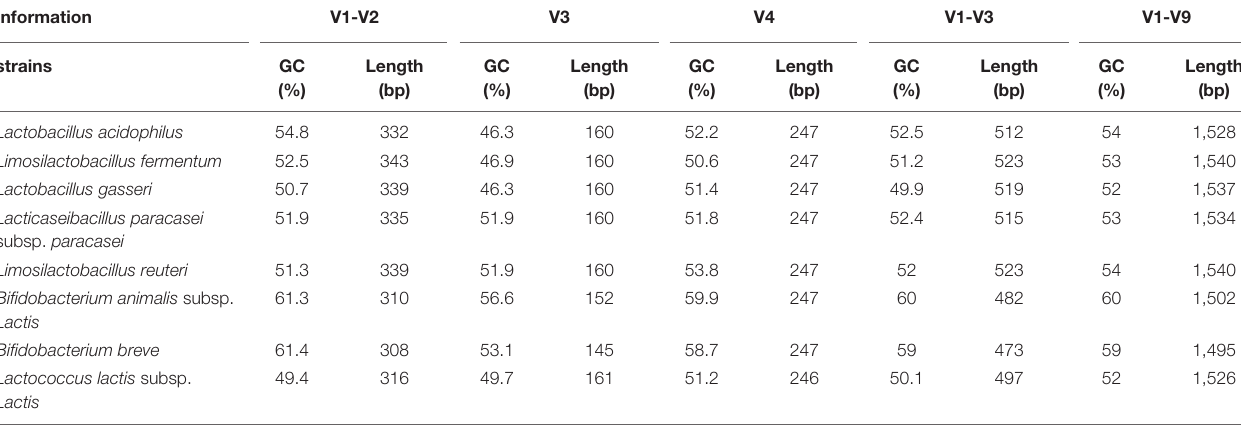
TABLE 3 | The information of GC contents and amplicon length in each sequencing region.